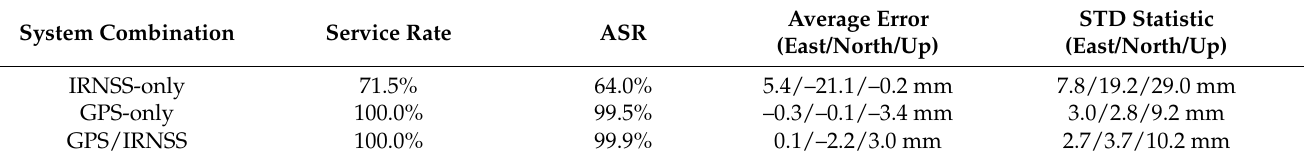
Table 4. Service rate, ASR, mean positioning bias, and STD value of the positioning error for the short-baseline RTK with different system combinations based on the datasets on 7–13 July